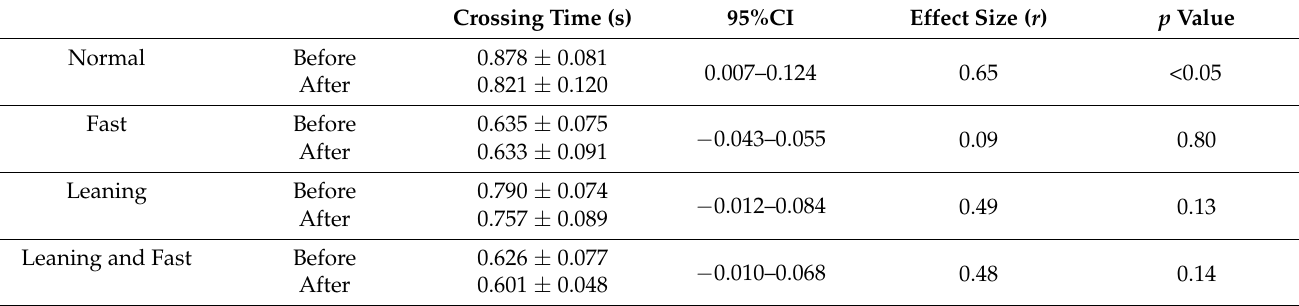
Table 7. Crossing time in the ATG for heel in anterior obstacle